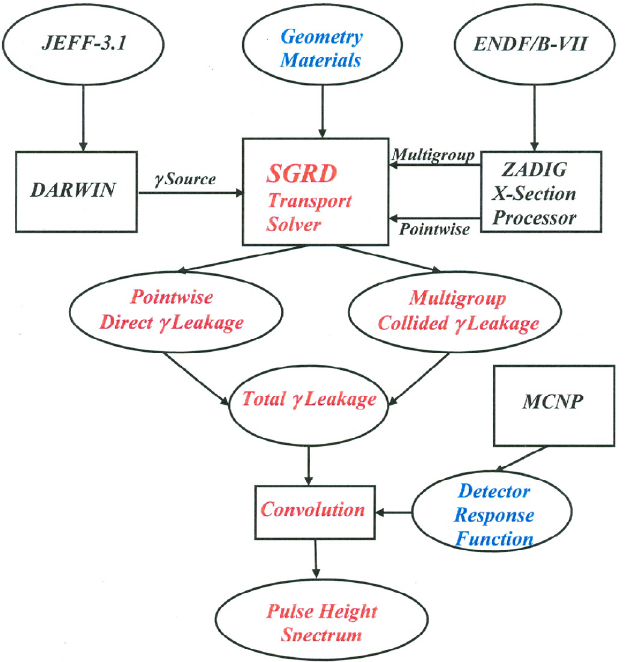
Fig. 1. SGaRD input/output fl ow diagram for gamma spectra calculation.